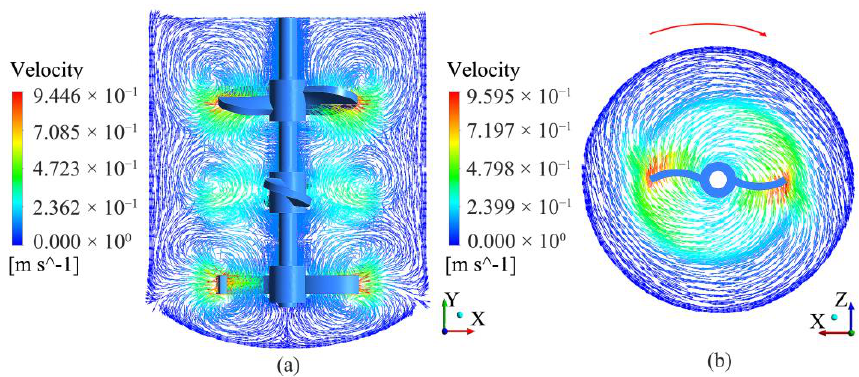
Figure 10. Velocity vector diagram when the medium is glycerin and Re = 55.5. ( a ) TBC-A type agitator, Plane 1:XY,Z = 0 mm; ( b ) TBC-A type agitator, Plane 3:XZ,Y = 70 mm.